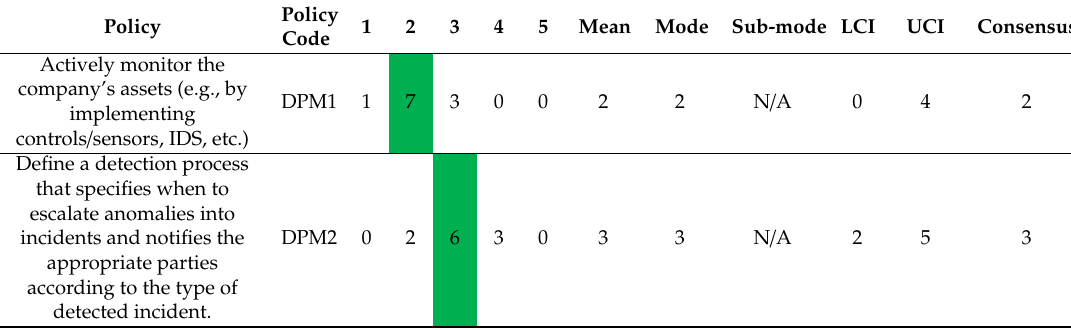
Table 23. Detection processes and continuous monitoring policies’ starting maturity.